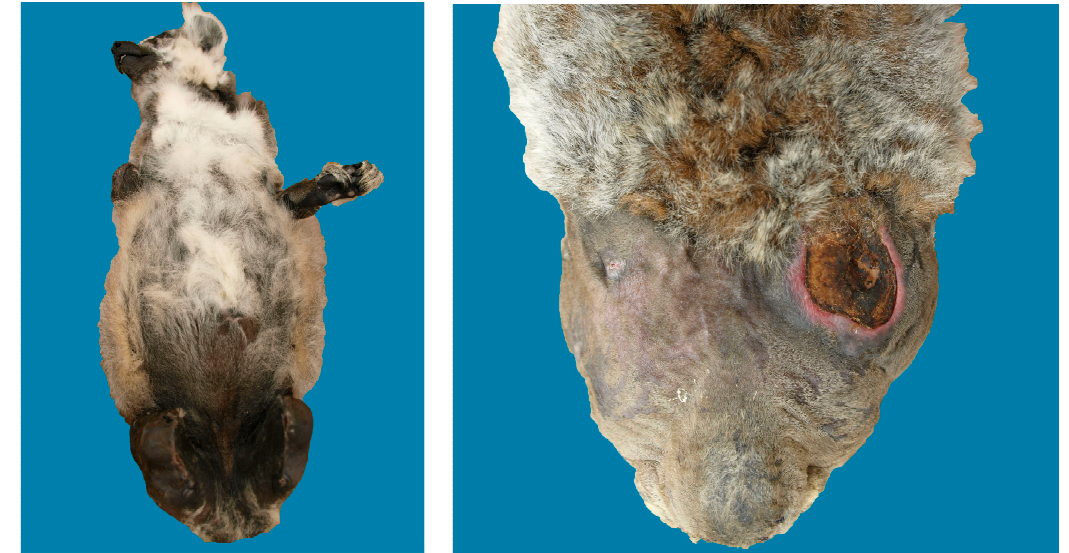
Figure 6. One-armed ring-tailed lemur presented for post-mortem examination ( left ); A deep suppurating ulcer was present on the dorsal trunk ( right ).